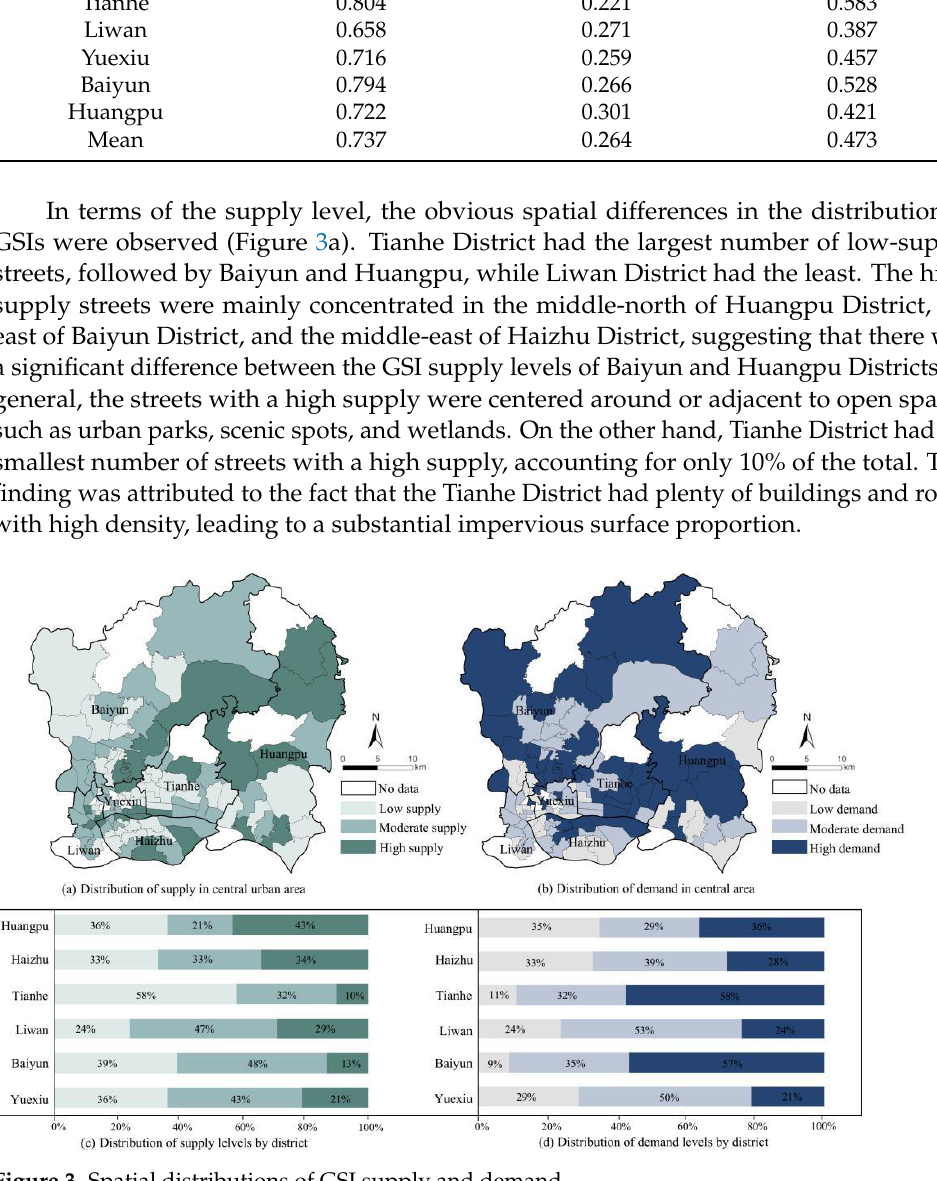
Figure 3. Spatial distributions of GSI supply and demand.